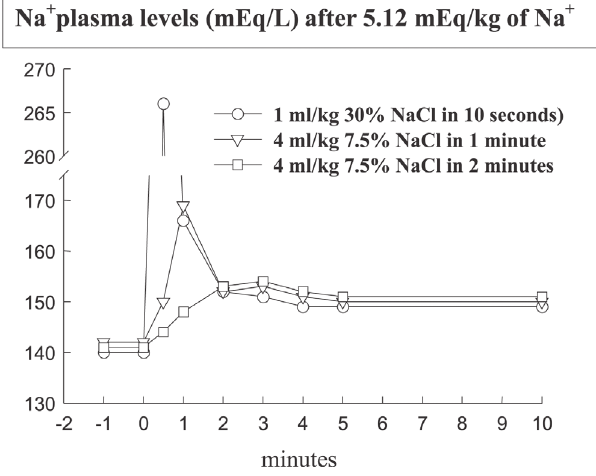
Figure 1 - Sodium plasma levels after intravenous injections of 5.12 mEq/kg de Na + to normovolemic anesthetized dogs. This sodium load was infused in three different regiments: as 30% NaCl in 10 seconds ( in circles ), as 7.5% NaCl in one minute ( in triangles ), and as 7.5% NaCl in two minutes ( in squares